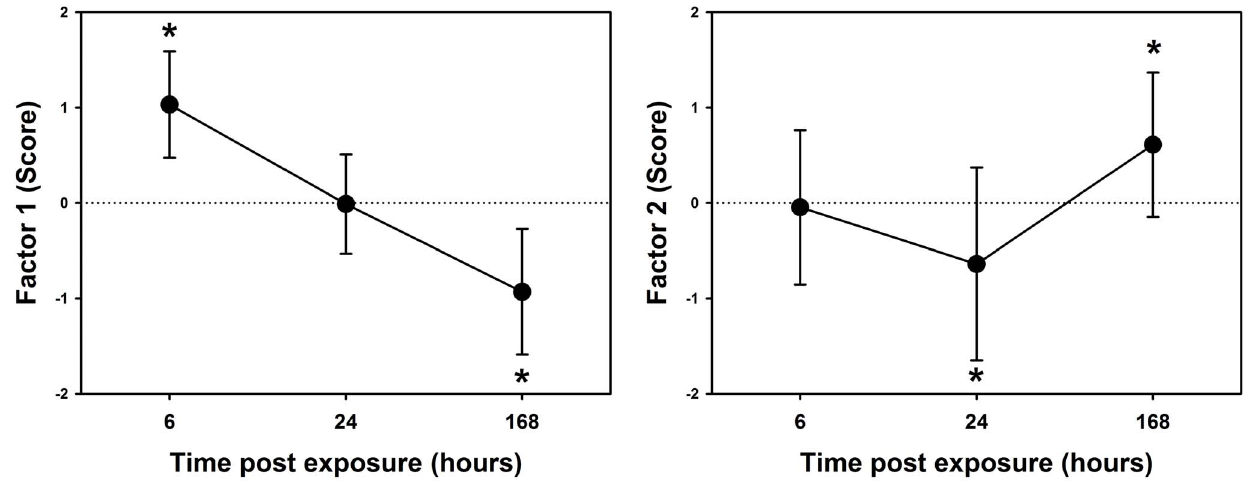
Figure 2. The lung response to geogenic particles was characterised by acute (6 hours post-exposure) inflammation and long term (7 days post-exposure) deficits in lung function. Mean(SD) scores for Factor 1 (inflammation, left) and Factor 2 (lung function, right) for all mice exposed to geogenic PM 10 obtained following principal components factor analysis. *indicated p , 0.05 against zero. doi:10.1371/journal.pone.0090609.g002 PLOS ONE |